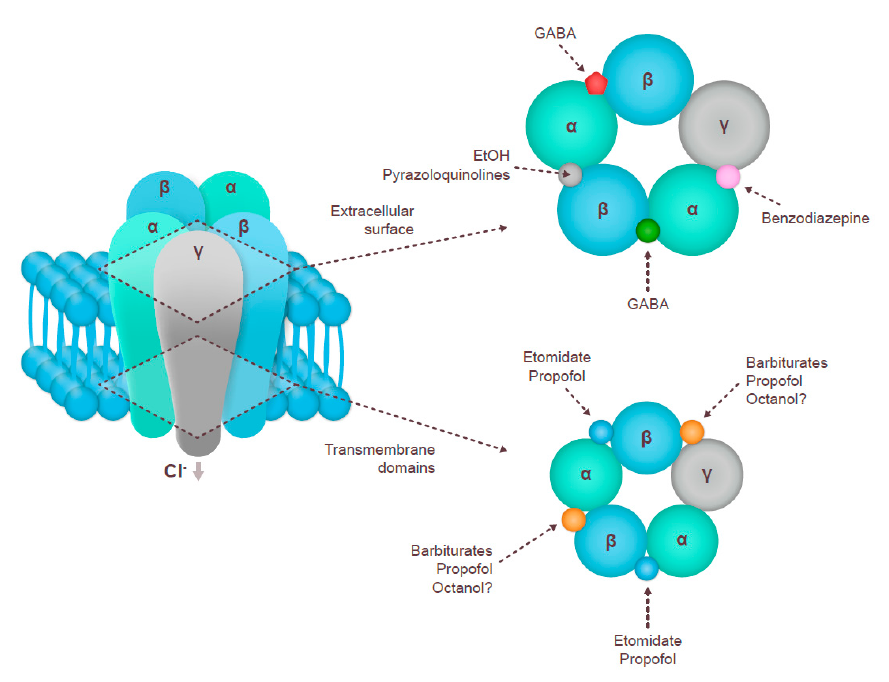
Figure 1. The structure of the GABA A receptor and the location of common agonist and antagonist binding sites [26,29–31]. Cl - , chlorine ions; GABA, gamma-aminobutyric acid; EtOH, ethanol. binding sites [26,29–31]. Cl − , chlorine ions; GABA, gamma-aminobutyric acid; EtOH, Barbiturates were the first generation of sedative/hypnotic drugs introduced in the early 20th century. Their binding site on the GABA A receptor is different from that of GABA, and they act via direct activation of the receptor. Barbiturates do not show selective affinity to different receptor compositions of GABA A . Second-generation sleep aids (benzodiazepines) are GABA A allosteric modulators that bind to the interface between the α and the γ subunits across a range of receptor compositions [27,29,31].